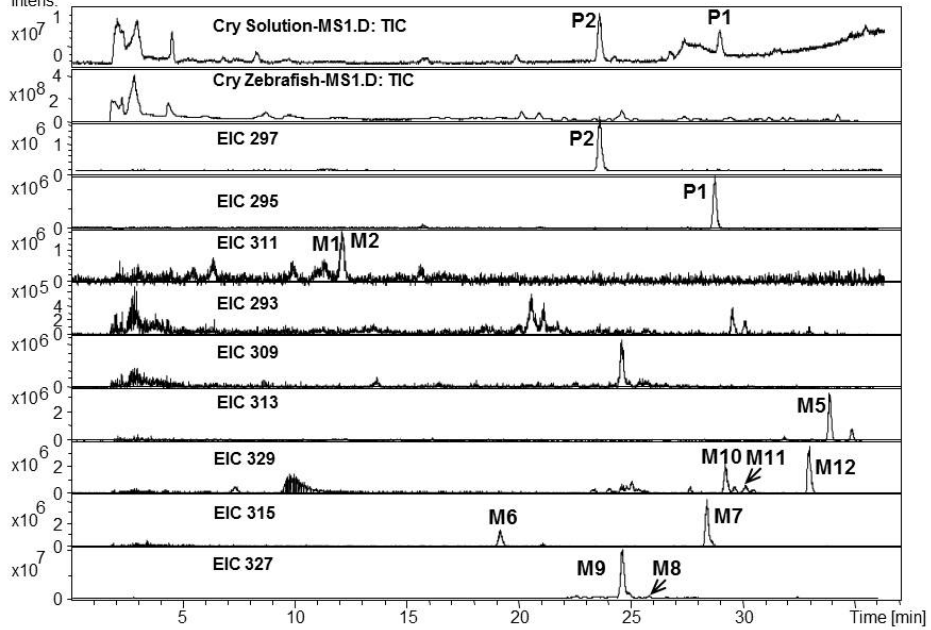
Figure 3. Total ion chromatogram and extracted ion chromatograms for Cry after exposure to zebrafish for 24